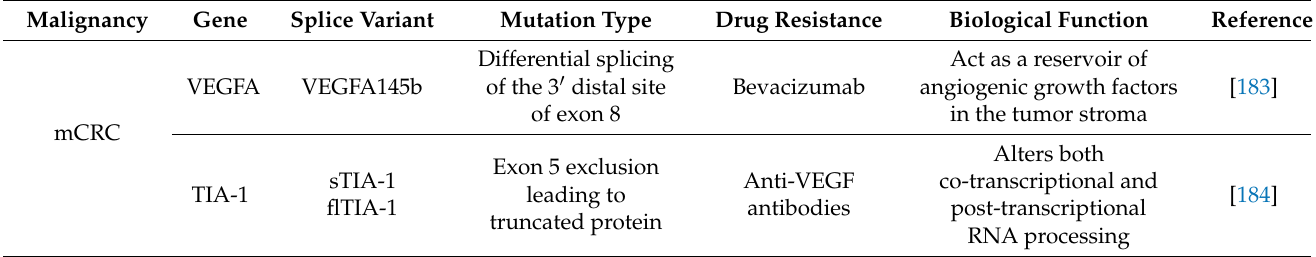
Table 5. AS and effects on drug resistance in